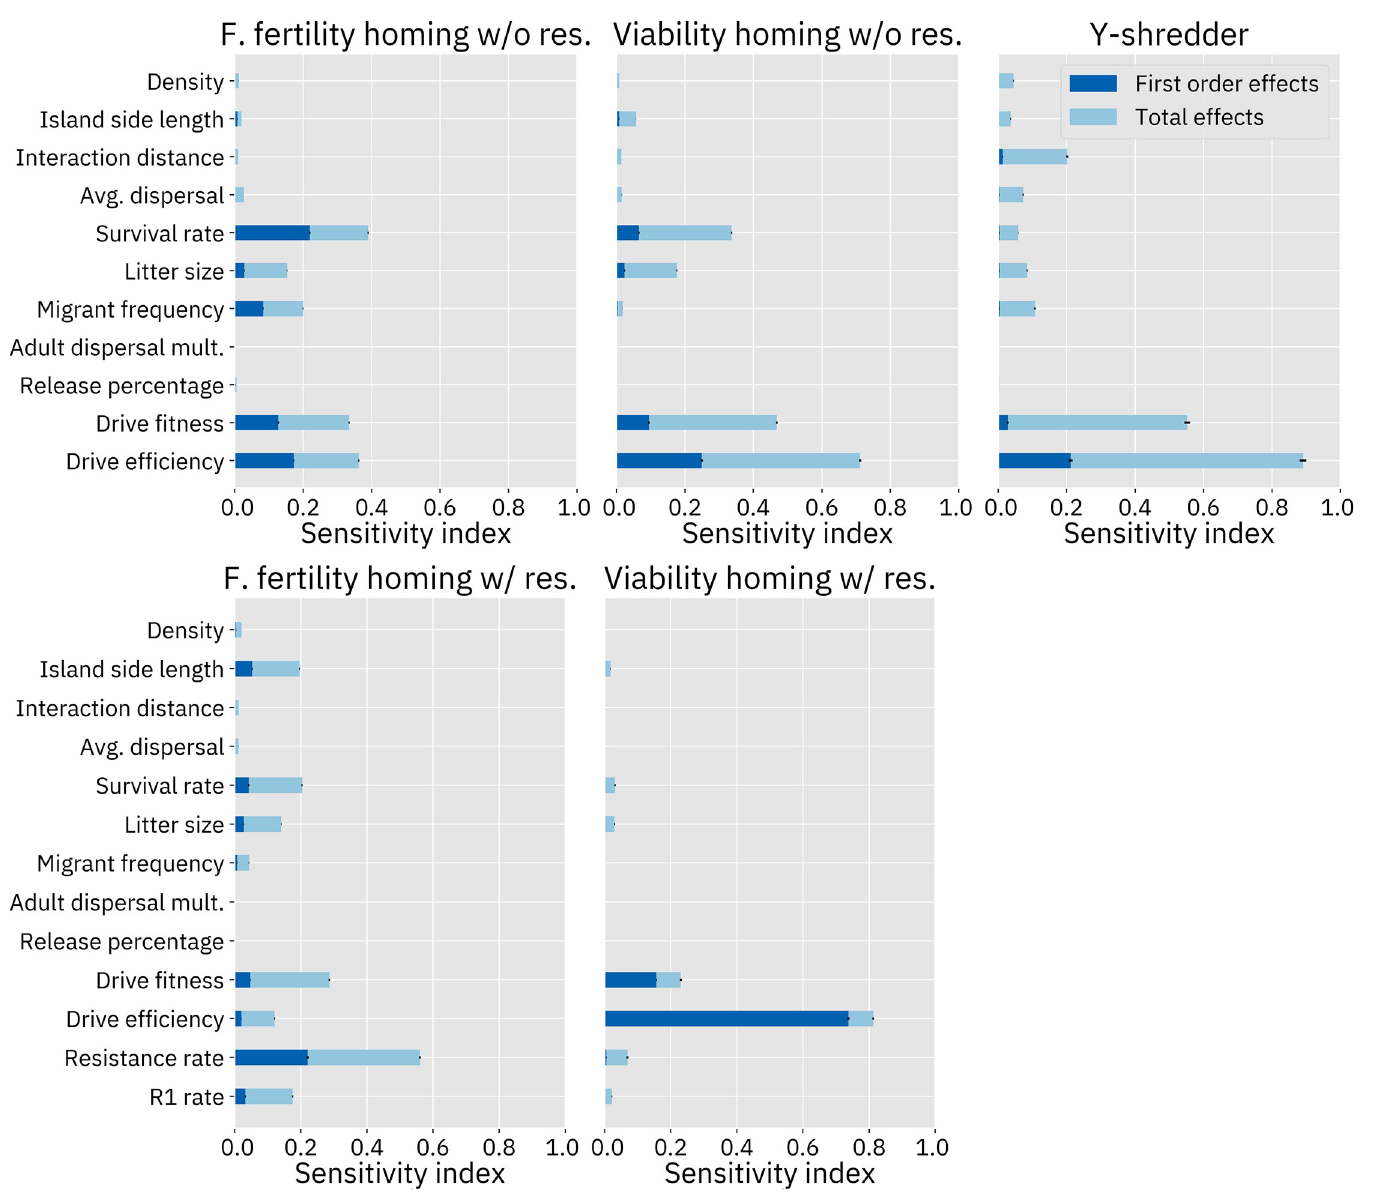
Fig 8. Sobol sensitivity analysis. “First order effects” describe the effects of varying a single parameter. “Total effects” include the first order effects of the parameter, as well as potential synergistic interactions between that parameter and one or more other parameters. Analyses of drive models without resistance sampled 24 million points from the parameter space. Analyses on drive models with resistance sampled 28 million points. These analyses are from the models trained on the suppression rate due to their somewhat better accuracy. Analyses of the composite model were similar.